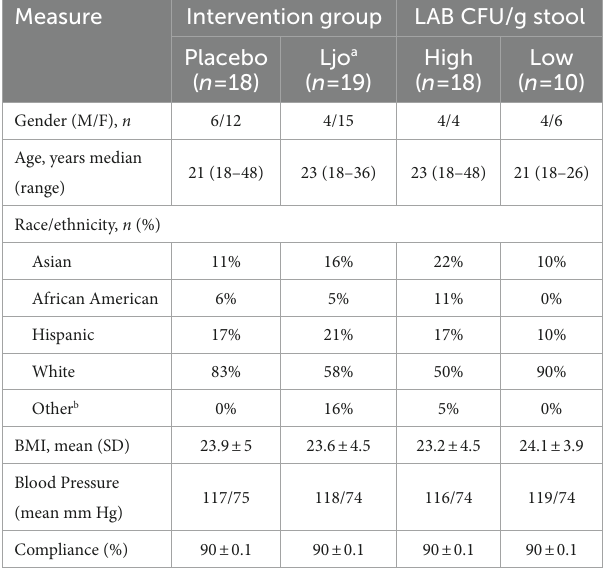
TABLE 1 Study adjusted demographics of individuals included in